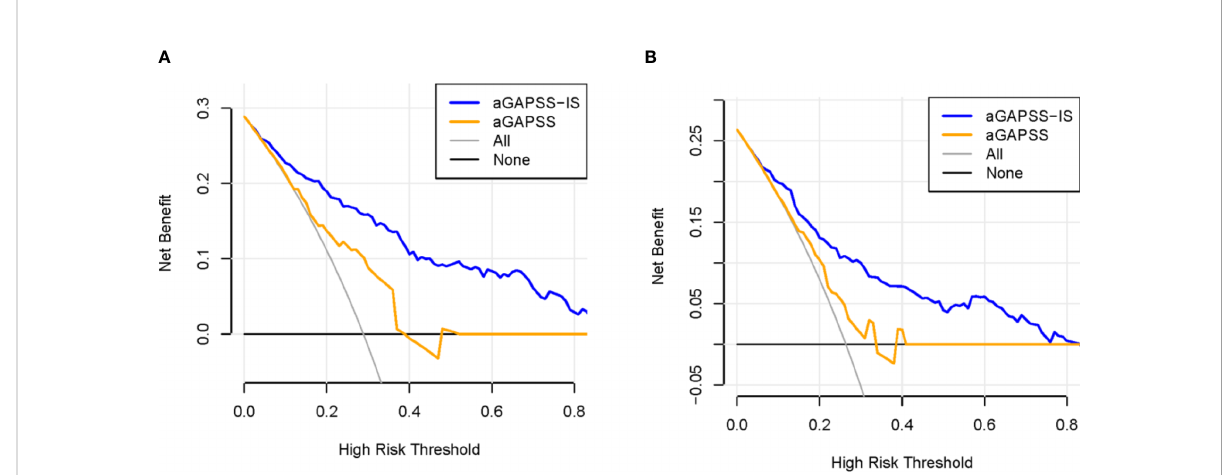
FIGURE 5 Comparison of the decision curves between the aGAPSS-IS score and aGAPSS in the training and the validation cohort. (A) For a threshold probability > 2%, application of the aGAPSS-IS score would add more net bene fi t to patients compared to the use of the aGAPSS in the training cohort. (B) For a threshold probability > 4%, the aGAPSS-IS score would provide more net bene fi t to APS patients than the aGAPSS in the validation cohort. aGAPSS adjusted Global Anti-Phospholipid Syndrome